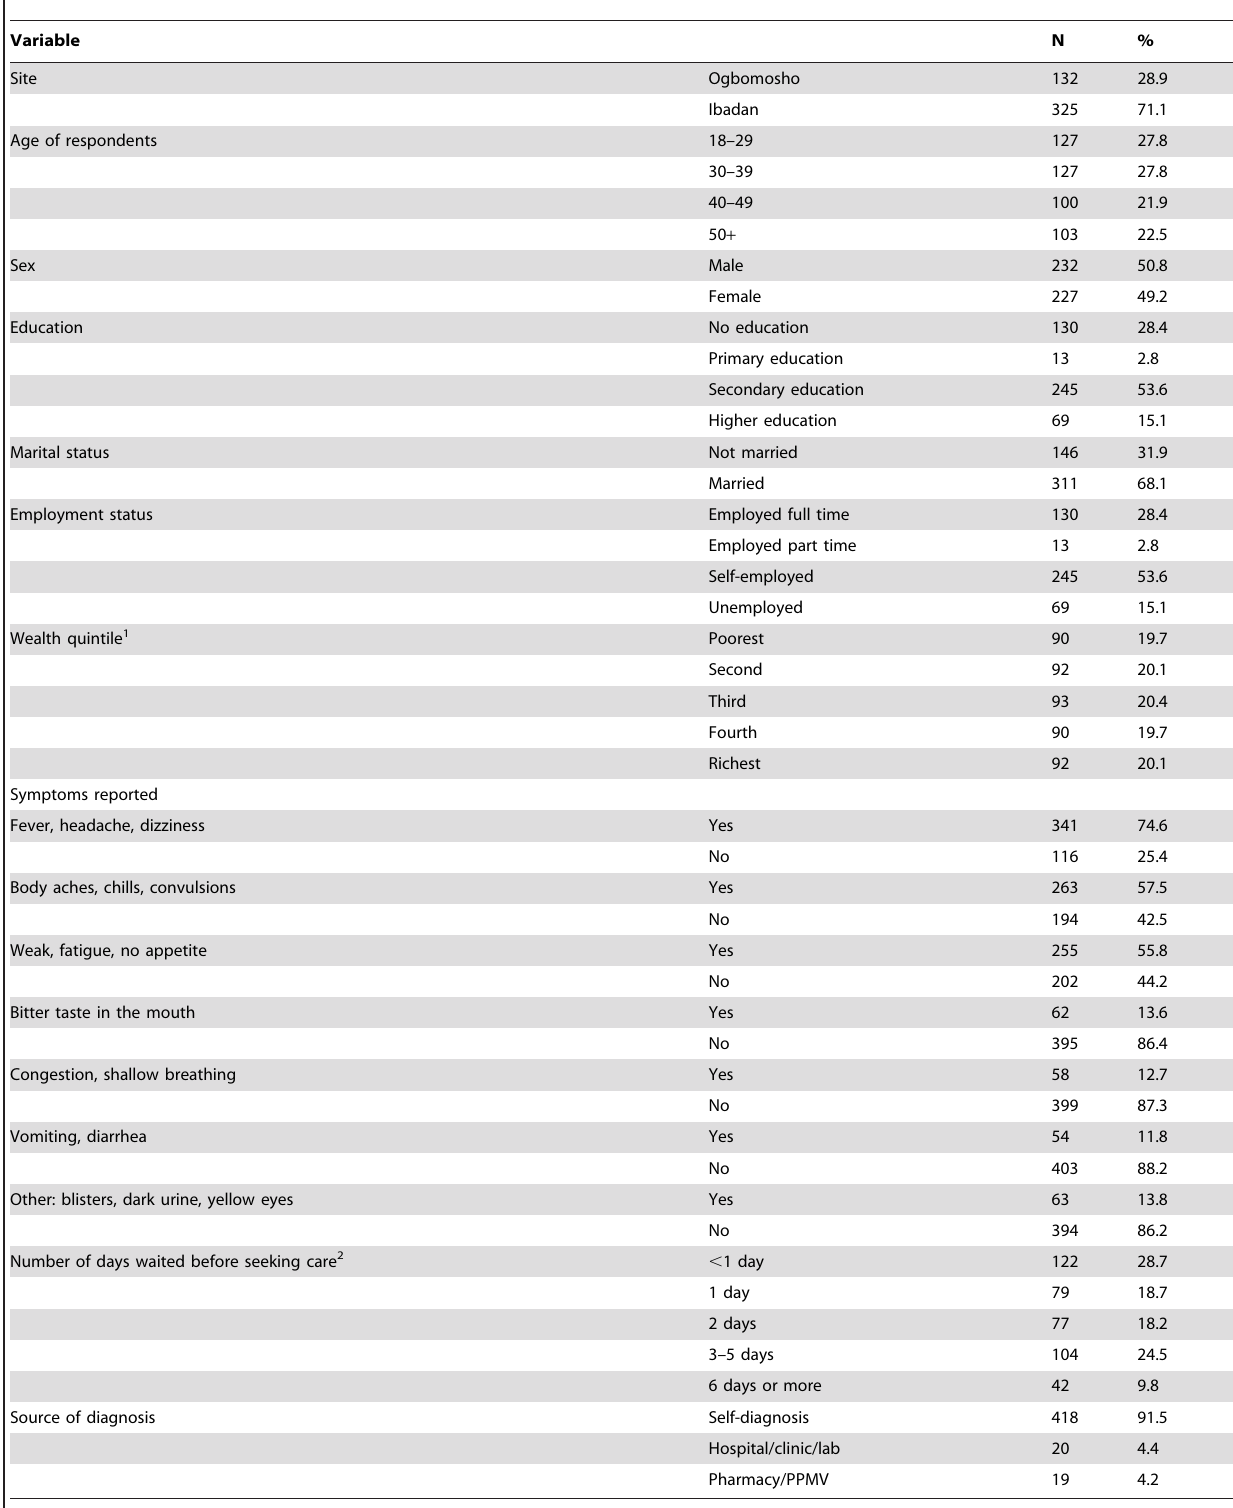
Table 1. Customer demographic and socioeconomic variables (N